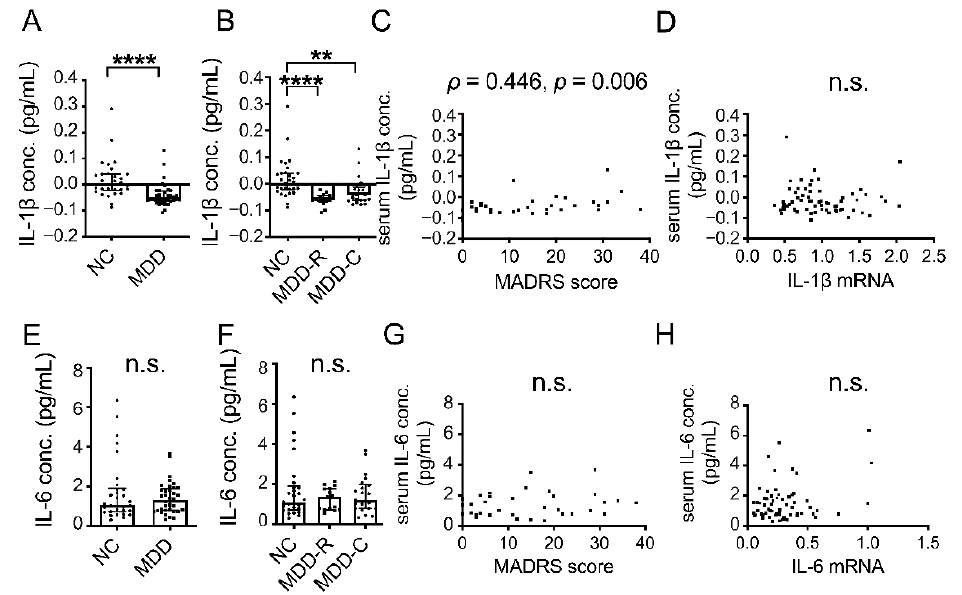
Figure 2. Serum concentrations of inflammatory cytokines in MDD and NC. Serum concentrations of IL-1 β ( A ) and IL-6 ( E ) in NC group and MDD group overall. Serum concentrations of IL-1 β ( B ) and IL-6 ( F ) in NC group, MDD remission group (MDD-R) and current MDD group (MDD-C). Horizontal lines indicate medians and error bars (IQR). ** p < 0.01. **** p < 0.0001. Correlation of MADRS score with serum concentration of IL-1 β ( C ) and IL-6 ( G ). Correlation between blood mRNA and serum concentration for IL-1 β ( D ) and IL-6 ( H ). n.s.: not significant.